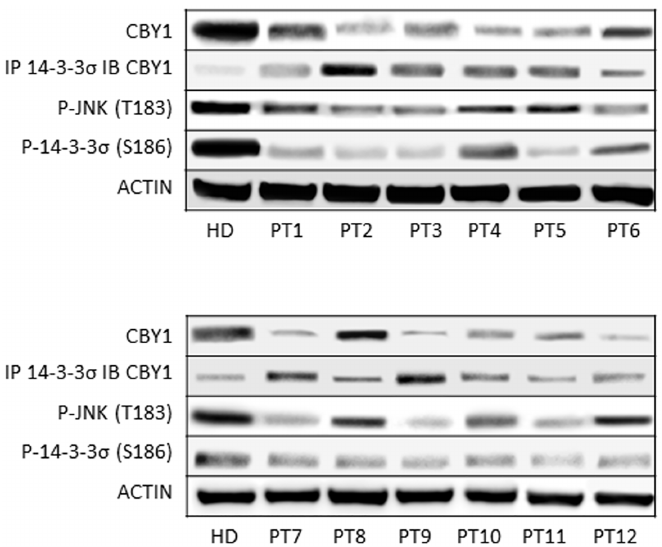
Fig 5. Reduction of JNK and 14-3-3 σ post-translational modifications is associated with CBY1 reduced expression and interaction with 14-3-3 σ in CML. Bone marrow MCF of 12 CML patients at diagnosis and 8 HDs were compared for CBY1 expression and interaction with 14-3-3 σ , JNK phosphorylation at threonine 183 and 14-3-3 σ phosphorylation at serine 186. Clinical details of CML patients included in our study are illustrated in the Supplementary section, S1 Table. A pool consisting of equal amounts of proteins from MCF of bone marrow samples of HDs was used as control for IP/IB to avoid individual differences. See legend to Fig 1 for technical details. The two blots shown here have been run separately and confirmed by two additional